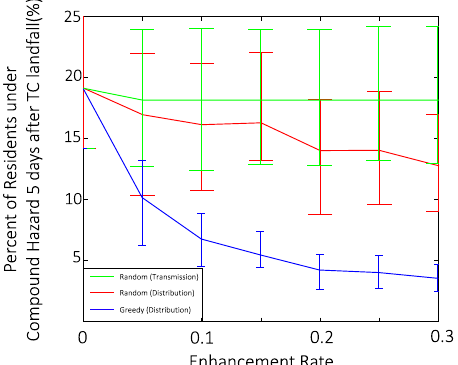
Fig.6|Reducedimpactoflonger-than-5-dayTC-blackout-heatwavecompound hazard under various risk mitigation strategies. Solid curves show the percen- tage ofaffected residents in a20-yearperiod inthe futureasa function of network enhancement rate with three strategies: randomly undergrounding power trans- mission networks (green),randomly undergrounding powerdistribution networks (red), and greedily undergrounding power distribution networks (blue). Curves show the expectation; error bars show the ±1 σ uncertainty